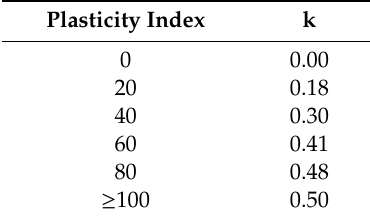
Table 1. Overconsolidation ratio exponent (Hardin and Drnevich,